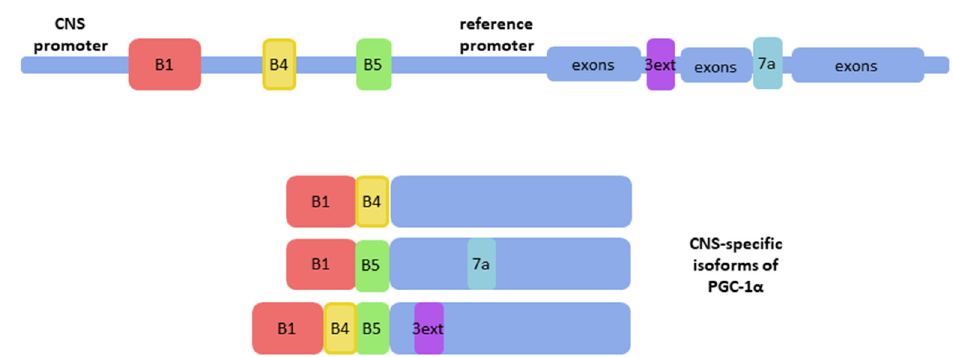
Figure 1. CNS-specific isoforms of PGC-1 α include exons localized upstream to the reference pro- moter; B1, B4, B5: CNS-specific exons (red, yellow, and green respectively); 7a and 3ext: alternatively spliced transcripts encoding stop codons in exon 7a or in an extension of exon 3 (blue and purple, respectively) (based on [26] and [27]).